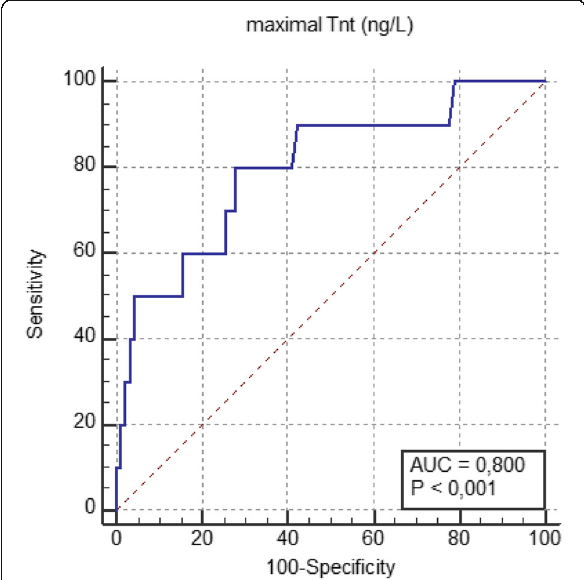
Fig. 1 (abstract 0199). ROC curve of maximal cTn-hs value for ICU mortality